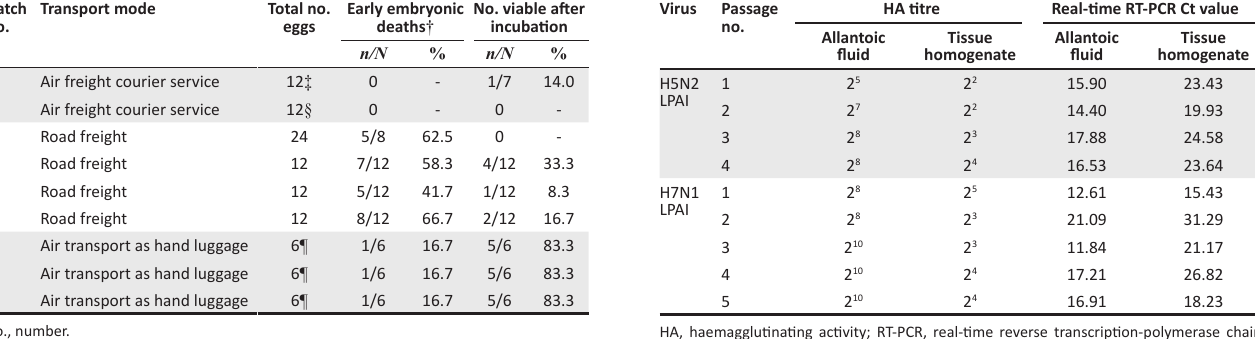
TABLE 2: Detection of influenza A viruses passaged in 28-day old embryonated ostrich eggs. Virus Passage no.